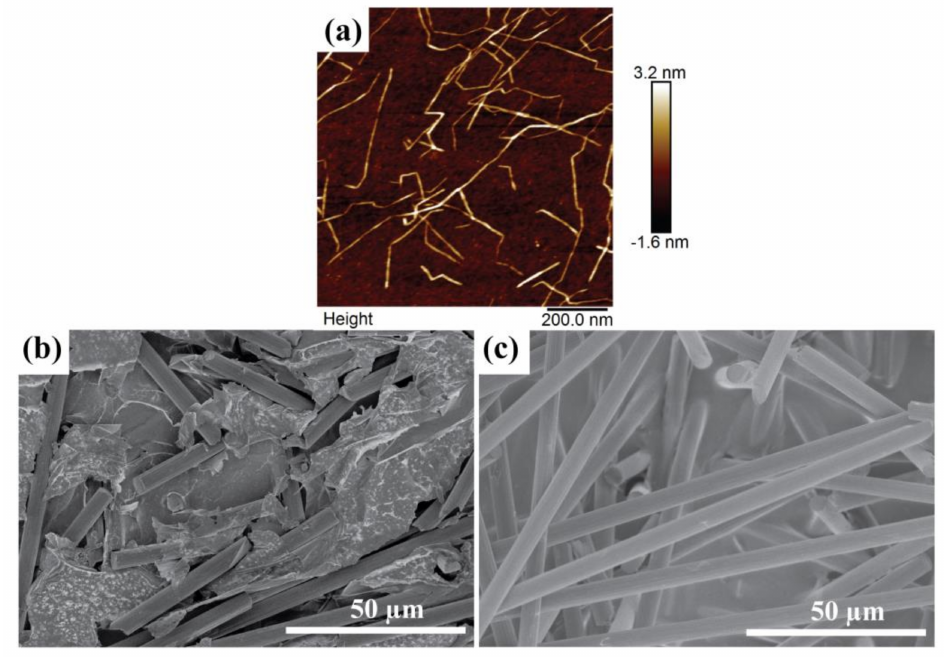
Figure 2. ( a ) AFM height image of CNF; SEM images of CF/CNF films from ( b ) smooth side; and ( c ) rough